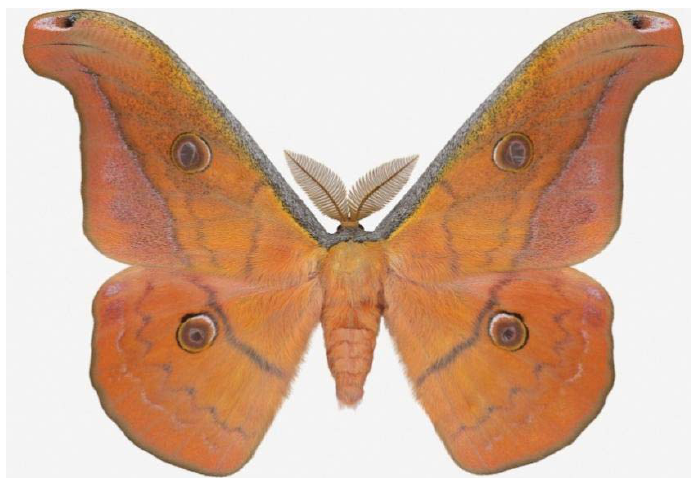
Figure 6. A large Sonoran silkmoth, Copaxa lavandera